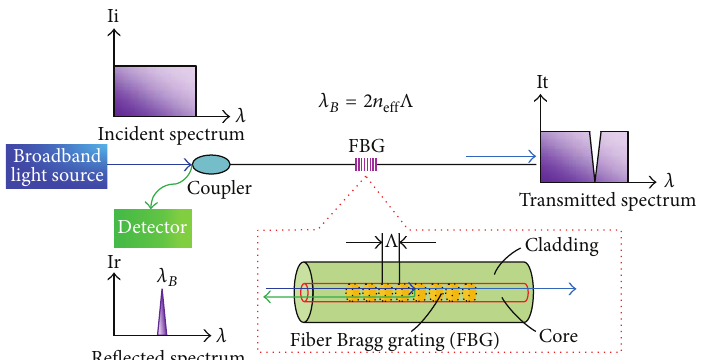
Figure 1: Measurement principal of FBG sensor.